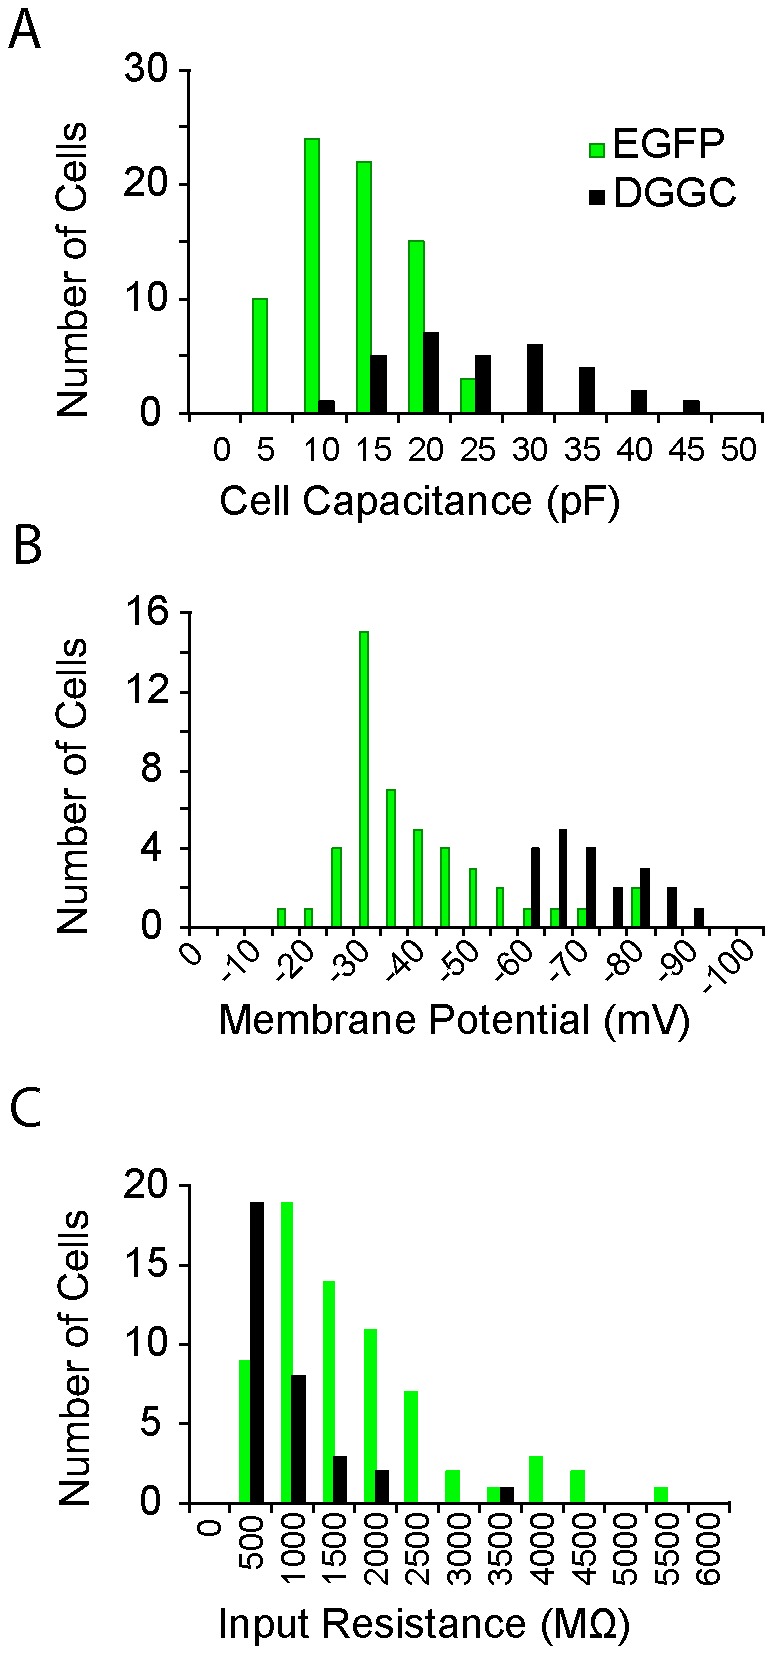
Intrinsic Properties of EGFP-expressing and Mature Granule Cells.Histograms of the whole-cell capacitance, resting membrane potential and input resistance demonstrate that EGFP-expressing granule cells (green lines) are typically smaller, more depolarized (though inaccurately measured, see text) and have a higher input resistance than mature dentate gyrus granule cells (DGGC, black lines).